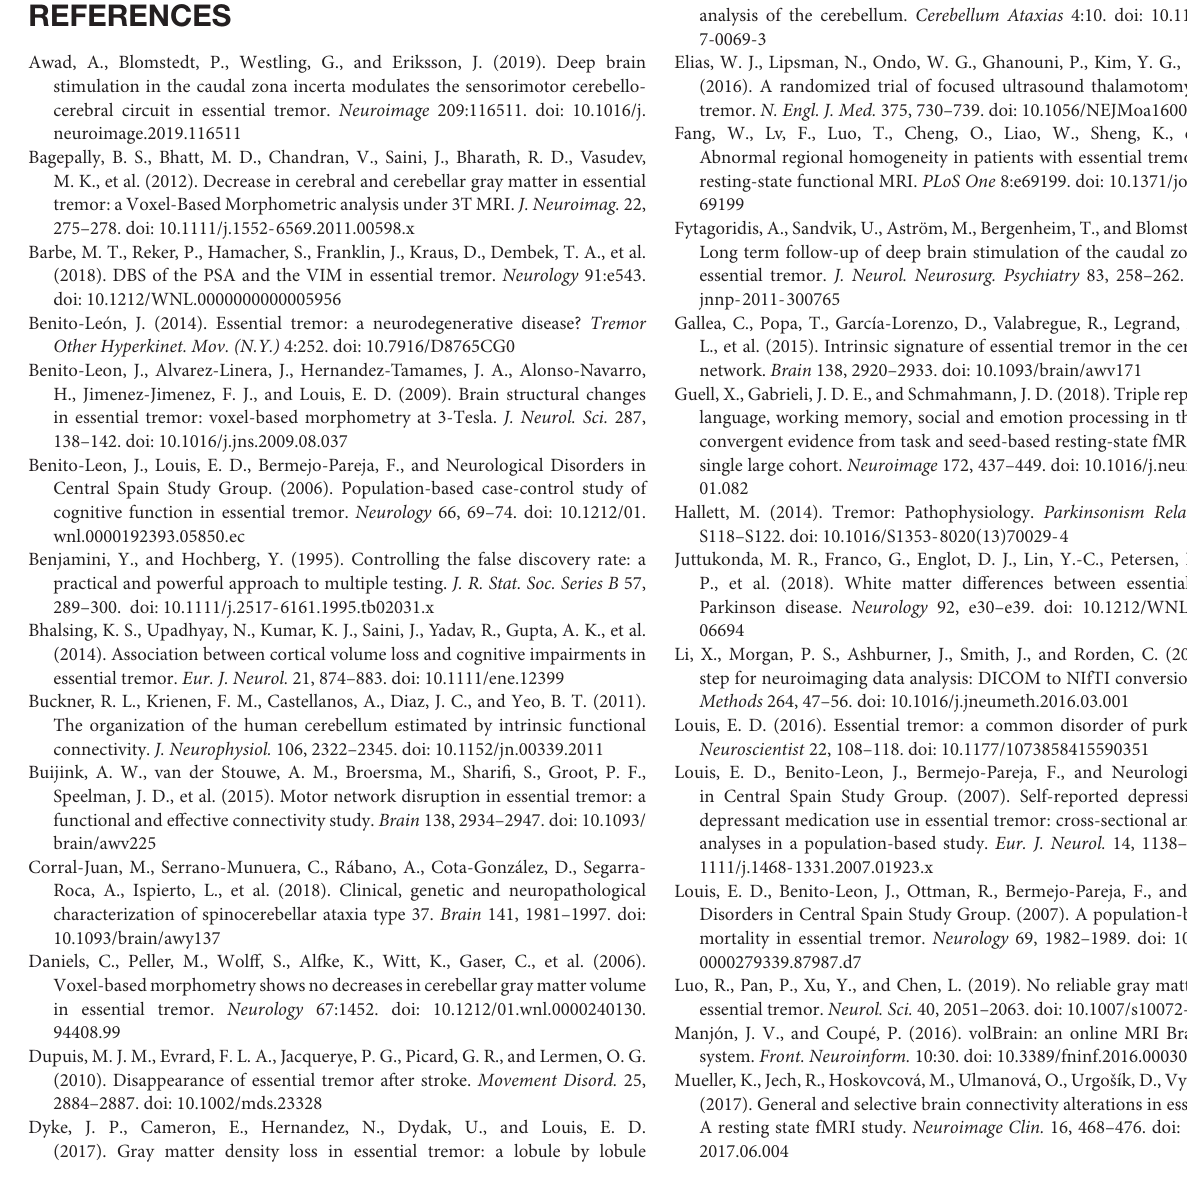
Supplementary Figure 1 | Violin plots of total brain volumes for healthy controls (HC) and patients with essential tremor (ET), determined using the volBrain pipeline (Manjón and Coupé, 2016). The bars represent medians and the 25th and 75th percentiles. The average values and statistics are presented in Table 1